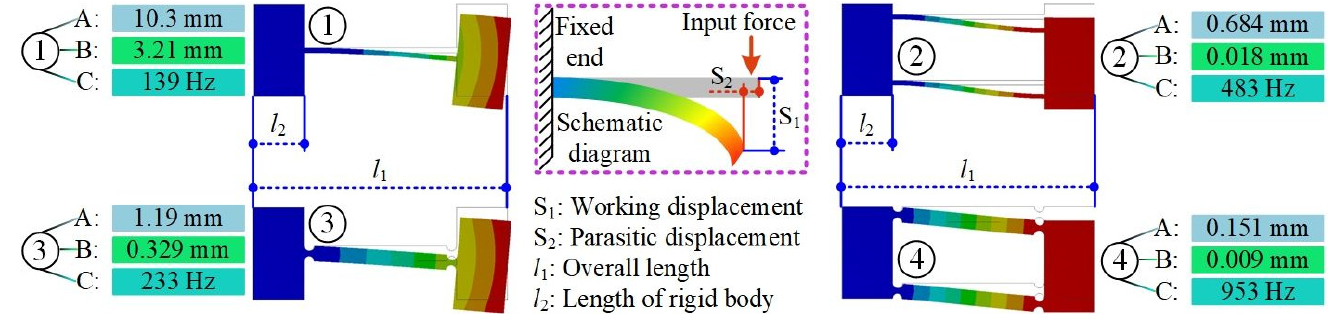
Figure 4. Comparison of transmission modules. A denotes the working displacement; B denotes the parasitic displacement; C denotes the first mode of beams.